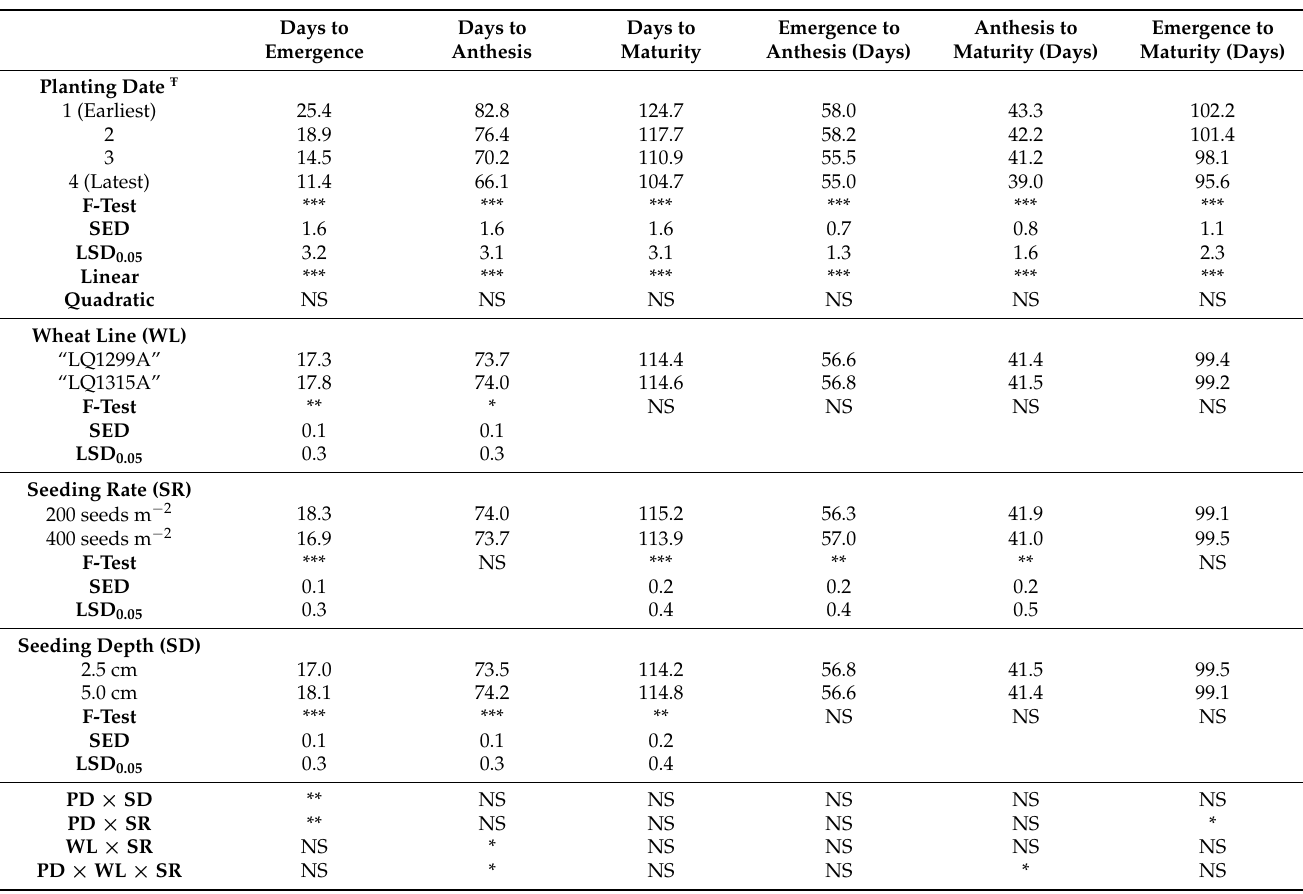
Table 4. Least square mean values for crop physiological development stage, duration, and related period lengths for Table 3. Least square means for grain yield, grain quality, and select agronomic parameters affected by ultra-early plant- ultra-early planted wheat. ing.